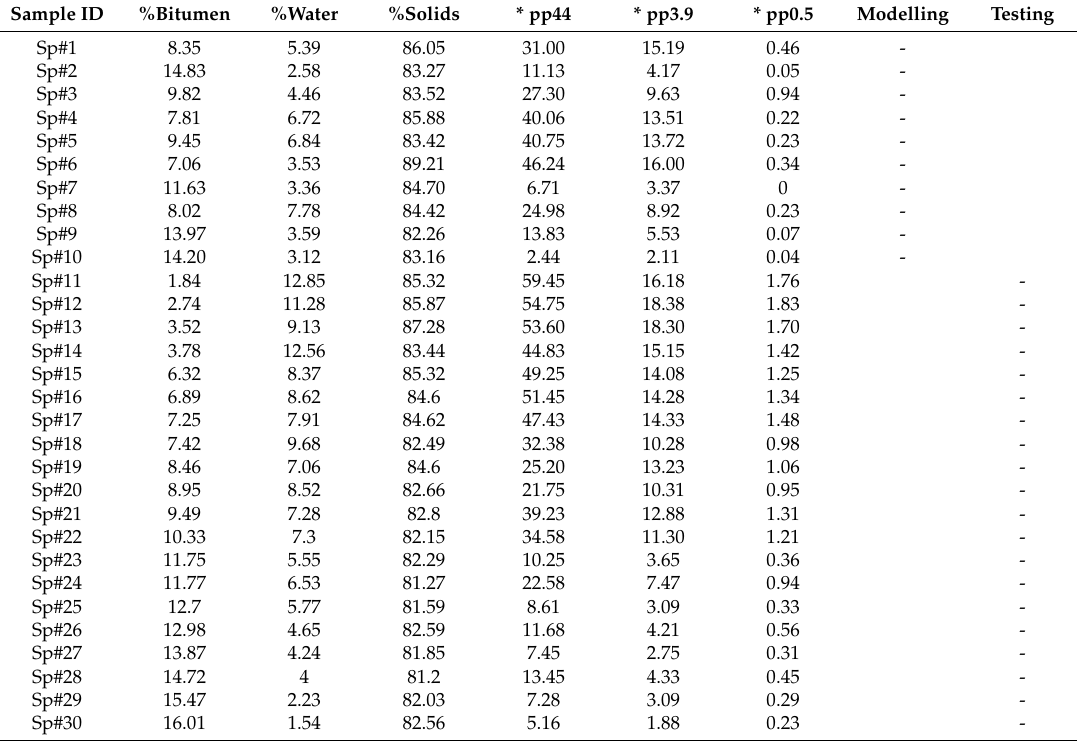
Table 1. Characteristics of the thirty oil sands ore samples used for the flotation experiment. Sample ID